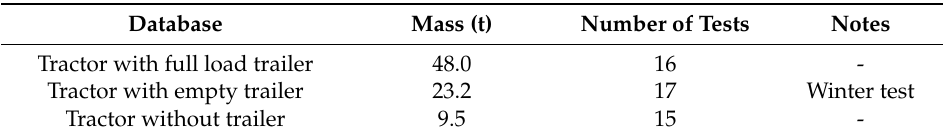
Table 4. Road test database with different loads.